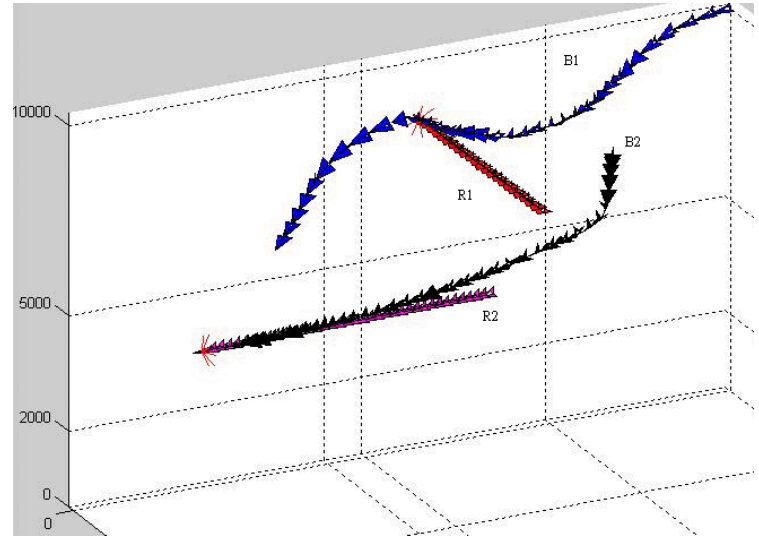
Figure 6. 2 × 2 drone aircraft air combat simulation.